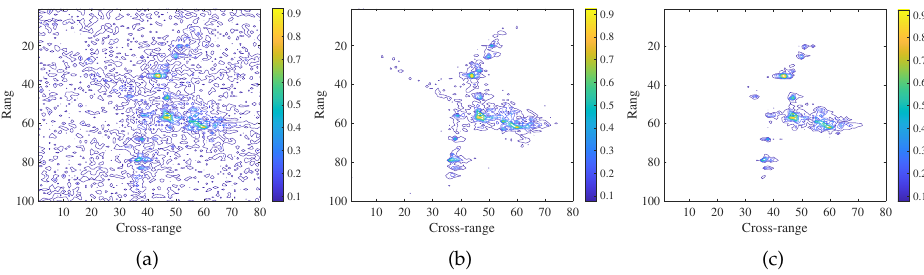
Figure 11. The imaging results of 25% measurements of plane data reconstructed by GDL method in the three cases of ( a ) λ = 0.01, ( b ) λ = 0.02, and ( c ) λ = 0.03.